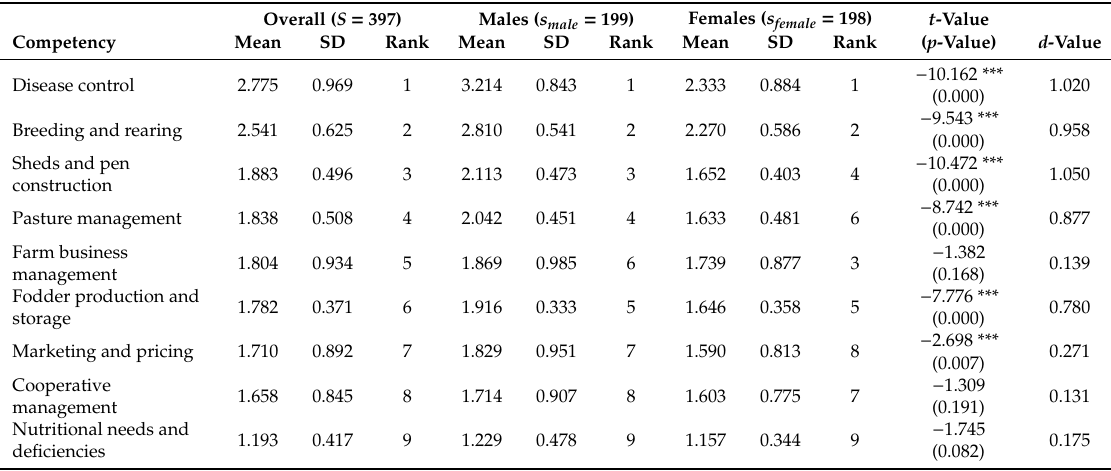
Table 4. Proficiency in production and management practices among beef cattle farmers. Overall ( S = 397) Males ( s male =